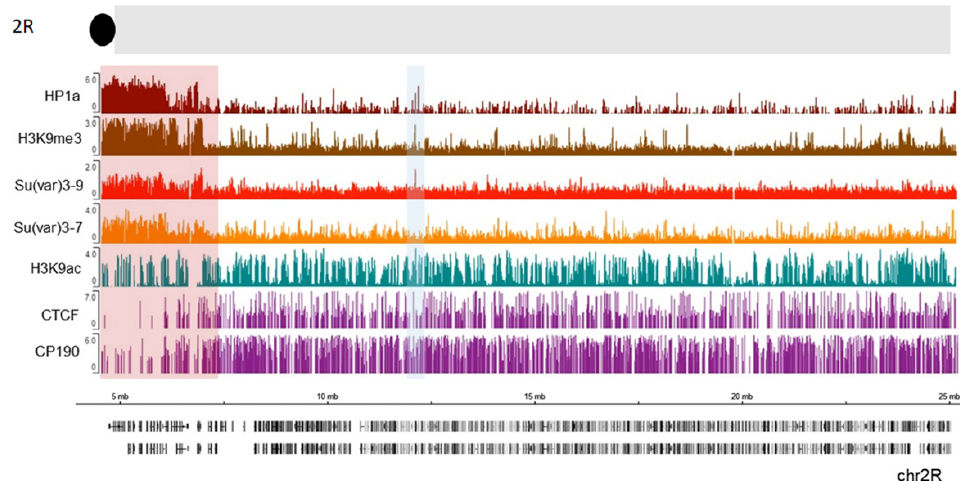
Figure 5. HP1a, together with other proteins, delimits epigenomic borders. Previously published ChIP data on S2 cells were used, where we see HP1a (dark red), Su(var) 3-9 (light red), Su(var) 3-7 (orange), H3k9me3 mark (brown), H3k9ac (green), CTCF, and CP190 (purple). The regions with a pericentric border are marked with a red rectangle according to Riddle et al. The co-localization of HP1a with H3K9ac mark is shaded in blue.